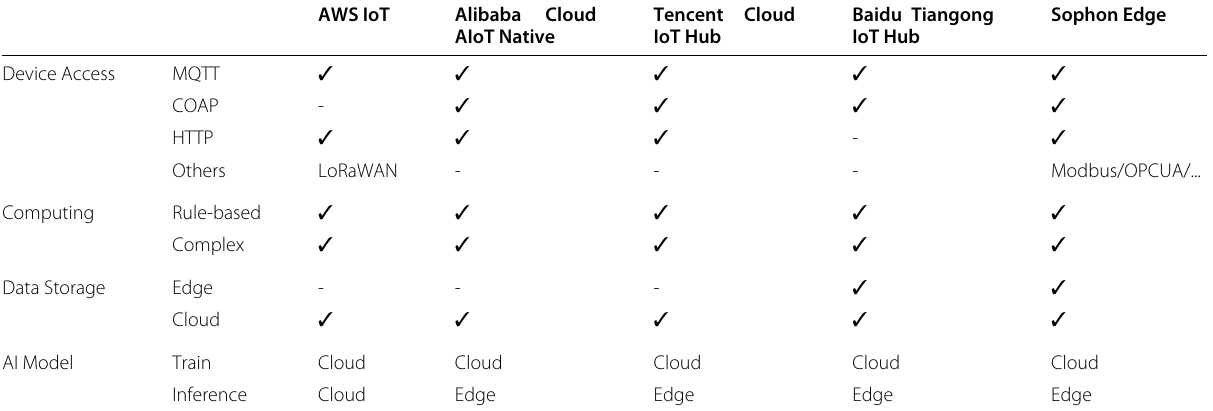
Table 3 Comparison of Sophon Edge and other AIoT platforms